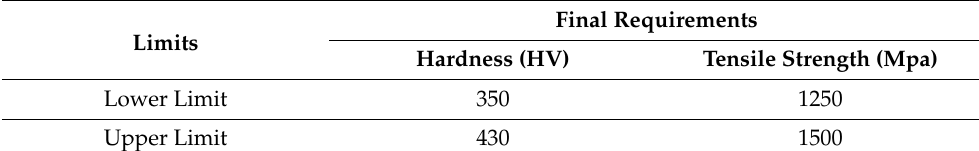
Figure 8. Predicted Output and Actual Output Comparison for Step 2 (For Test Dataset).